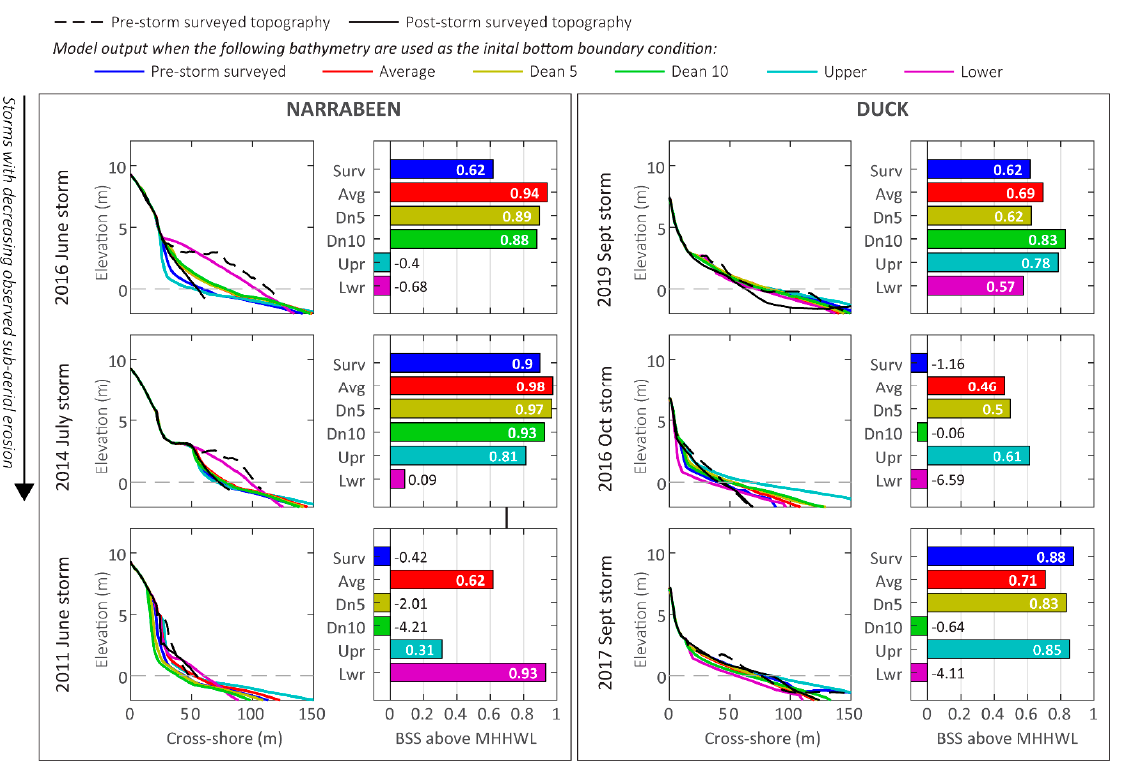
Figure 6. Modelled post-storm profiles and the associated skill for the calibration storms, corresponding to each of the six bathymetries: Pre-Storm Surveyed (blue); Average (red); Dean5 (yellow); Dean10 (green), Upper (cyan); Lower (purple). Briar skill scores (BSS) are calculated for the sub-aerial section of the profile above MHHWL, corresponding to the elevation 0.7 m at Narrabeen and 0.6 m at Duck. Model performance varied significantly for the two bathymetries Upper and Lower , that together represent the upper and lower envelope of all available surveys of the surf zone and nearshore bathymetry at each site. Despite being an end member in the envelope